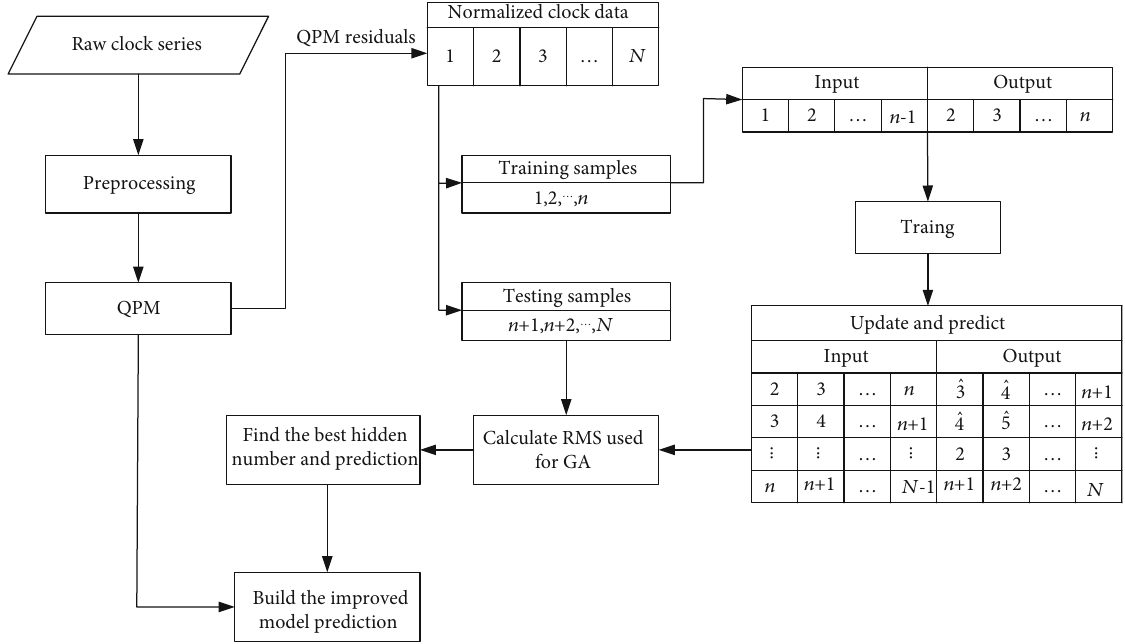
Figure 4: Algorithm fl ow chat of